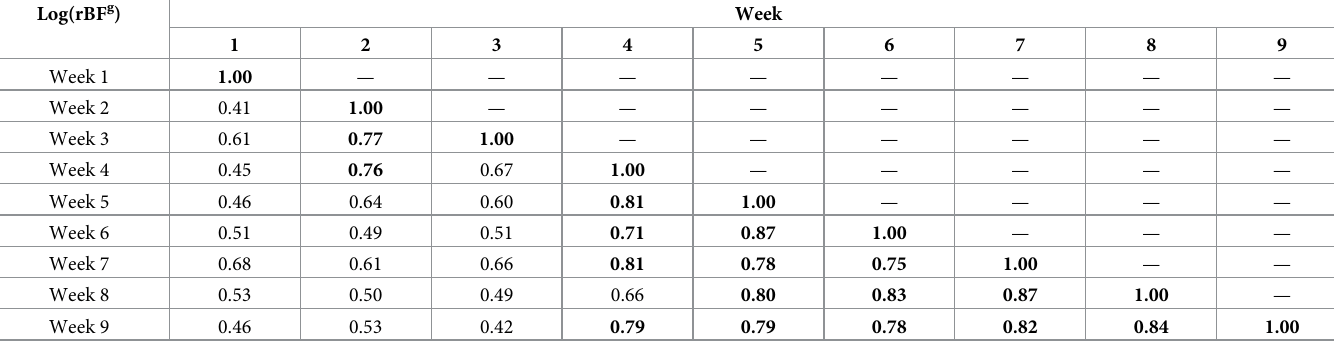
Table 1. Correlation coefficients of log( rBF g ) at different weeks of all mice (N = 19). ( Bold : correlation coefficient > 0.7). Log(rBF g )